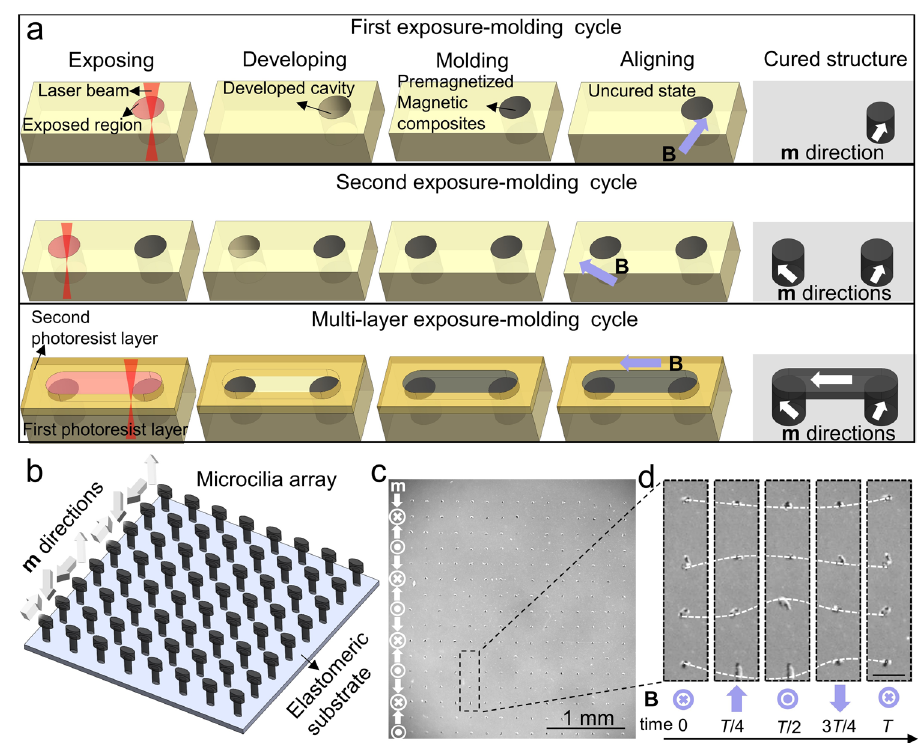
Fig. 1 Concept of the multi-step direct laser writing (DLW)-molding process and example showcase of a fabricated magnetic microcilia array. a The exposure-molding cycle using 2PP 3D lithography with positive photoresist. Three exemplary molded structures are shown: two standing pillars in the fi rst photoresist layer and a connecting beam in the second photoresist layer. After fi lling the developed cavity with pre-magnetized magnetic composites in each step, excess material is wiped away from the surface, and an external B fi eld will be applied to align the magnetic particles before the composites are cured. b Schematic of the fully-soft micro-cilia array with each row encoded with different magnetic moment ( m ) directions which are marked by arrows. c Microscopic image of the microcilia array immersed in water. The directions of the arrows mark the m directions of all the cilia in that row. The dashed area corresponds to the zoomed-in region. d Video (Supplementary Movie 1) frames of the zoomed-in region showing four cilia with different m directions bending under an out-of-plane rotating magnetic fi eld. The fi eld is 15 mT and rotates at 0.8 Hz. White dashed lines trace the tip position of each cilium. T denotes the period of time of the ciliary beating cycle. Scale bar: 100 µ